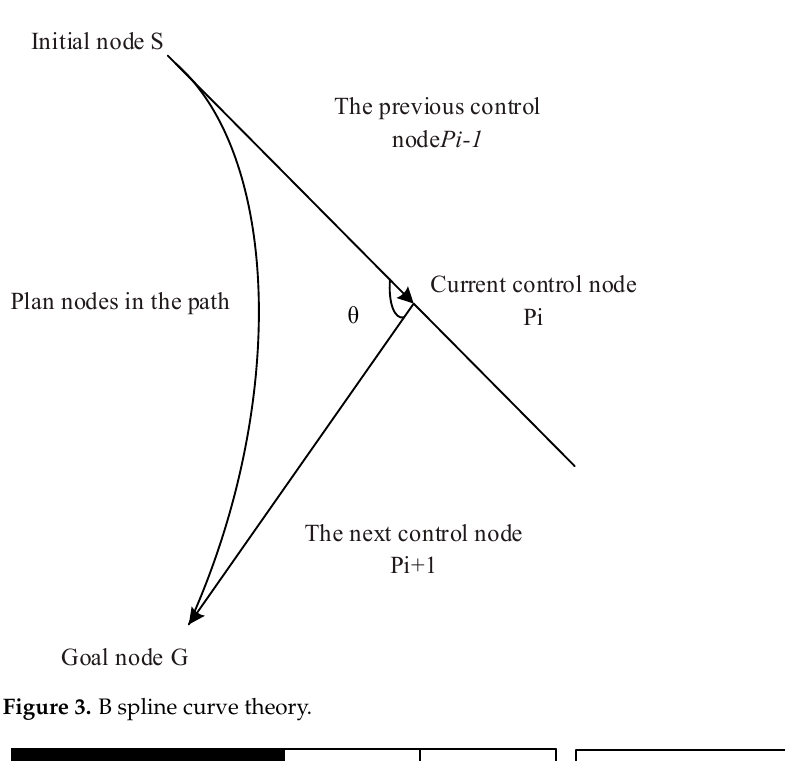
Figure 3. B spline curve theory.